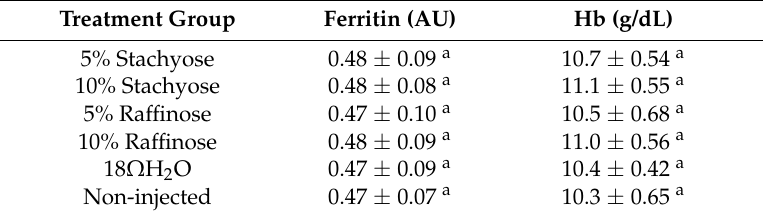
Table 3. Liver Ferritin protein amounts (AU) and blood hemoglobin (Hb) concentrations (g/dL). Values are means ± SEM, n = 10. a Treatment groups not indicated by the same letter are significantly different ( p <